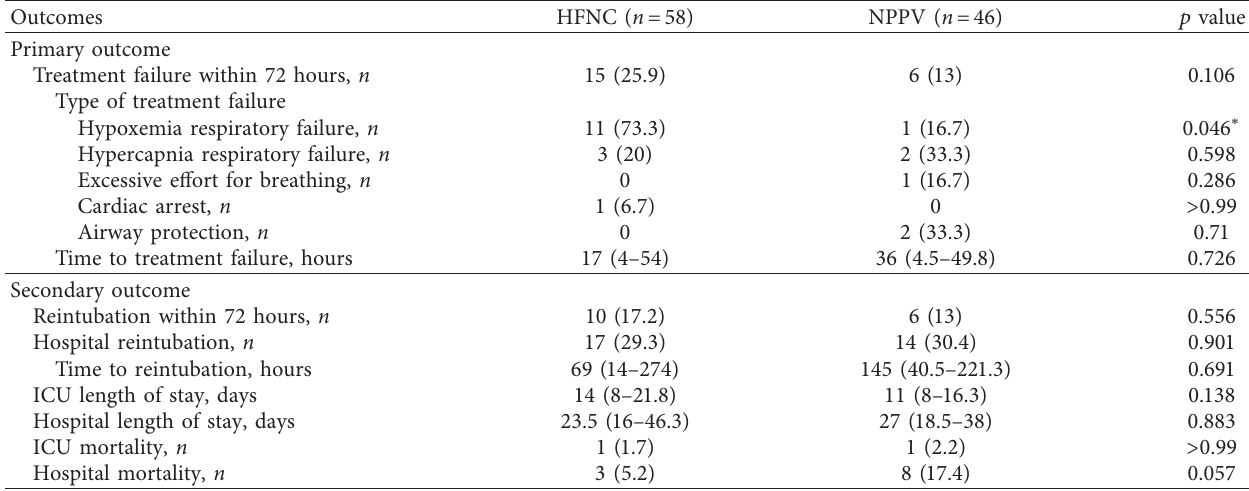
Table 2: Outcomes of patients between the HFNC and NPPV groups.